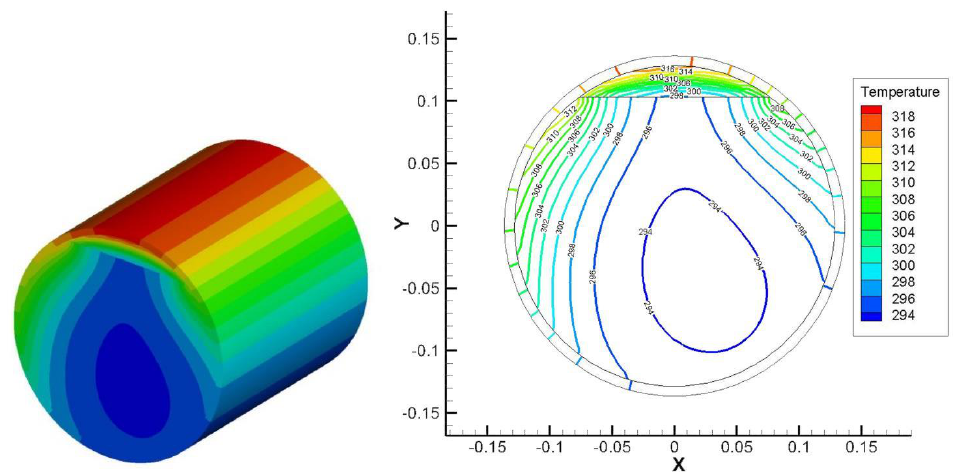
Figure 5. Temperature cloudy map and isopleth at 30° (unit: K).